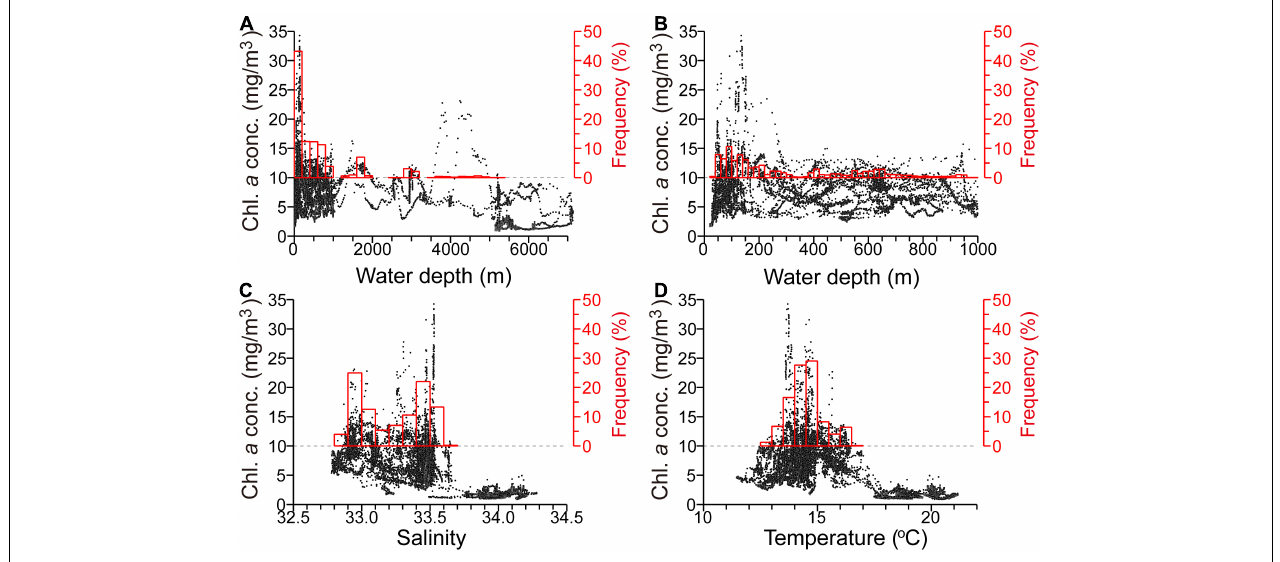
FIGURE 5 | Scatter plots of surface chlorophyll- a concentration along the ship track versus (A) water depth (for all measured depths), (B) water depth (for depths < 1,000 m), (C) sea-surface salinity, and (D) sea-surface temperature. For each panel, frequency distributions of chlorophyll- a concentrations exceeding 10 mg m − 3 are denoted by red bars, corresponding to the red right-hand axis (%).